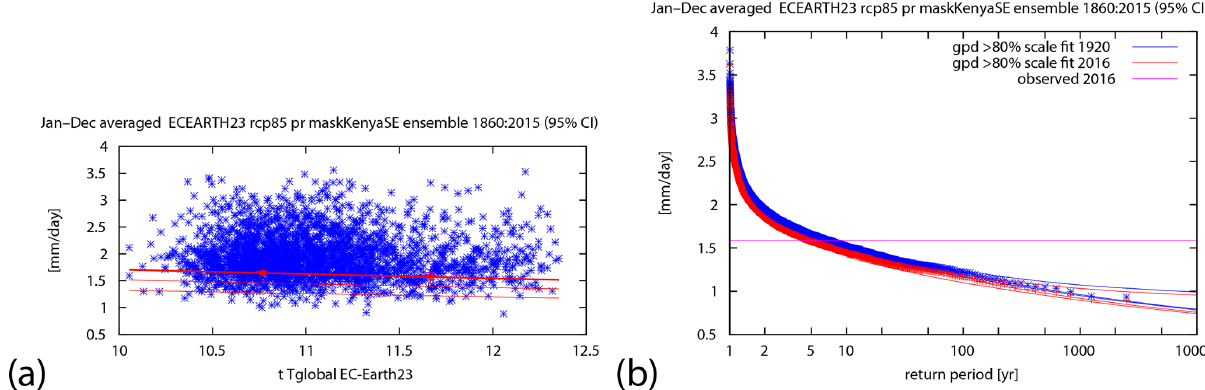
Figure 8. Similar to Fig. 4 but for the low precipitation event in the south-east of Kenya in 2016, using a GPD that scales with GMST and evaluated for the years 1920 and 2016. The figures show data of the 16 ensemble members of the EC-Earth model and the fit uses the lowest 20% of the data. See Uhe et al. (2018) for more